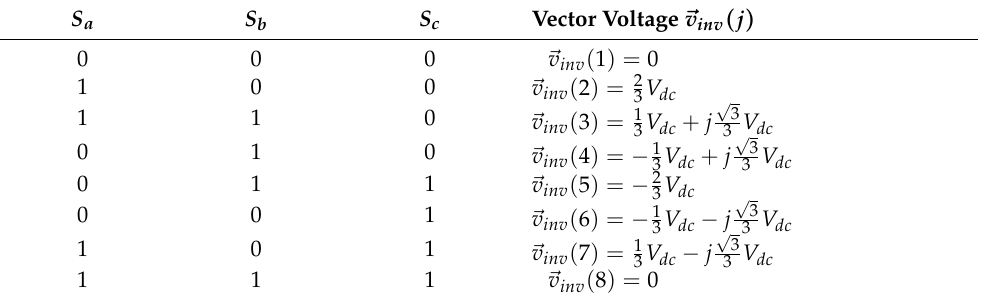
Table 3. Switching states and voltage vectors of the